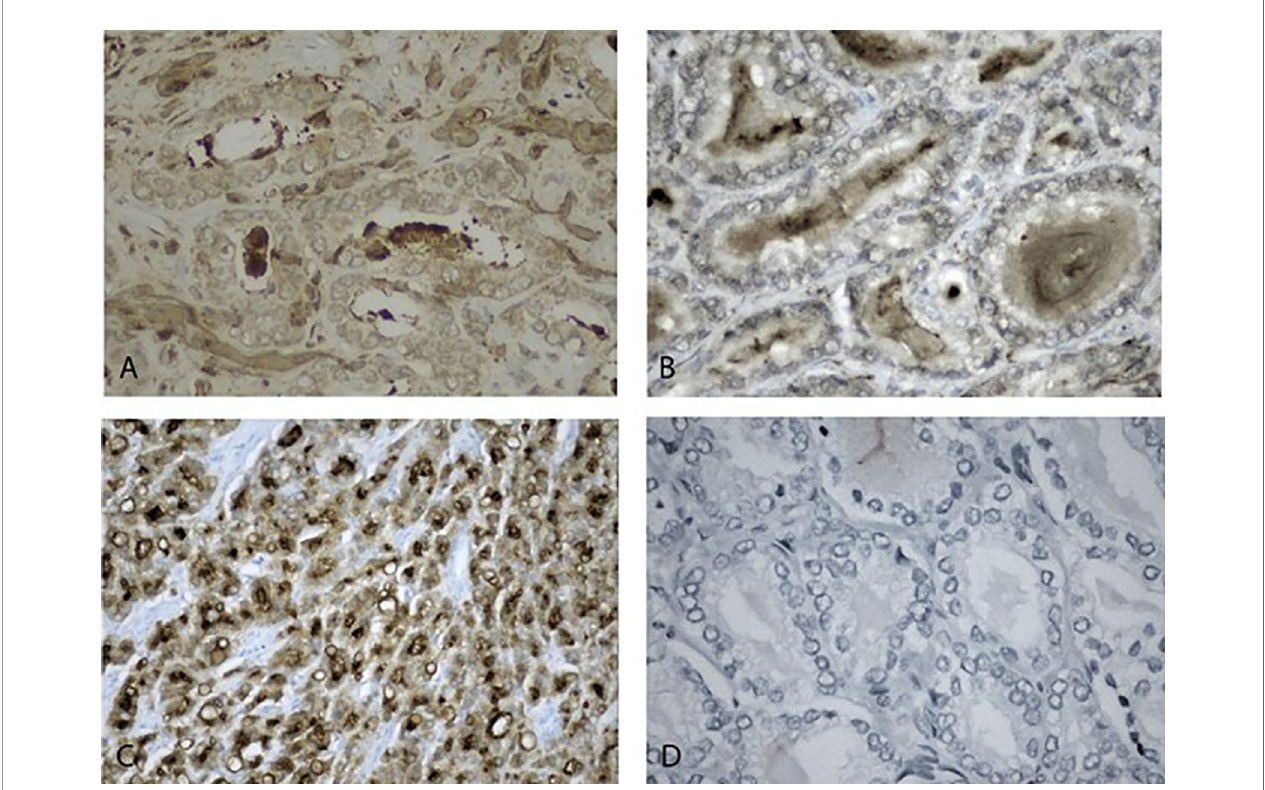
FIGURE 1 | Immunohistochemistry staining of positive and negative expression of biomarkers. (A) positive GRPR low-grade prostate neoplasms 40x. (B) Negative high-grade prostate neoplasms, 40x. (C) Positive PSMA high-grade prostate neoplasms, 20x. (D) negative PSMA low-grade prostate neoplasms,